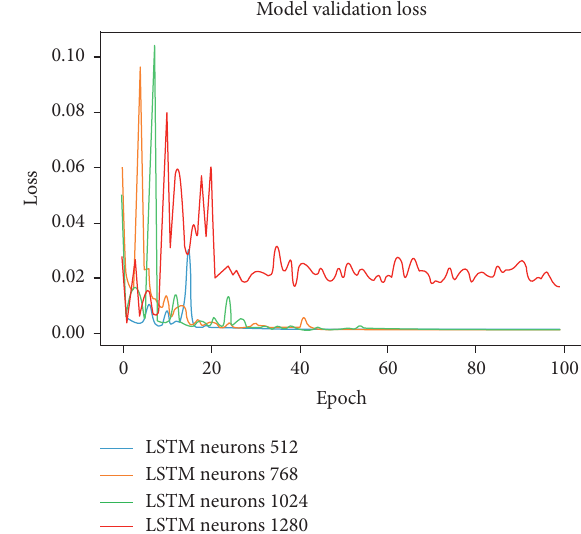
Figure 7: Learning curve with different numbers of LSTM neurons.